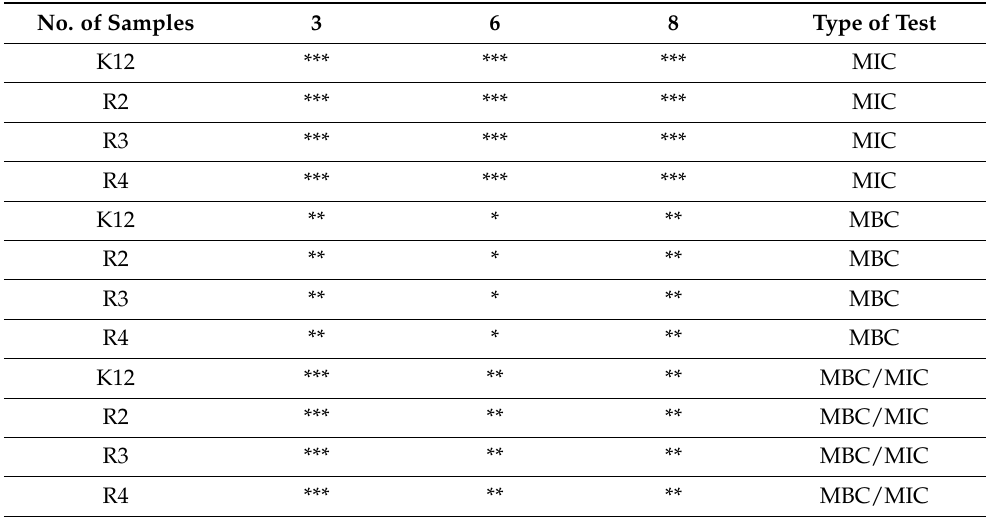
Figure 5. The ratio of MBC/MIC of the benzylphosphonate derivatives. The x -axis features compounds 1 – 8 used sequentially. The y -axis shows the MBC/MIC value in µg/mL. Investigated strains of E. coli K12 as control (blue), R2 strains (orange), R3 strain (grey), and R4 strain (yellow). The order in which the compounds were applied to the plate are shown in Supplementary Materials Figure S22. Table 1. Statistical analysis of all analyzed compounds by MIC, MBC, and MBC/MIC; <0.05 *, <0.01 **, <0.001 ***.